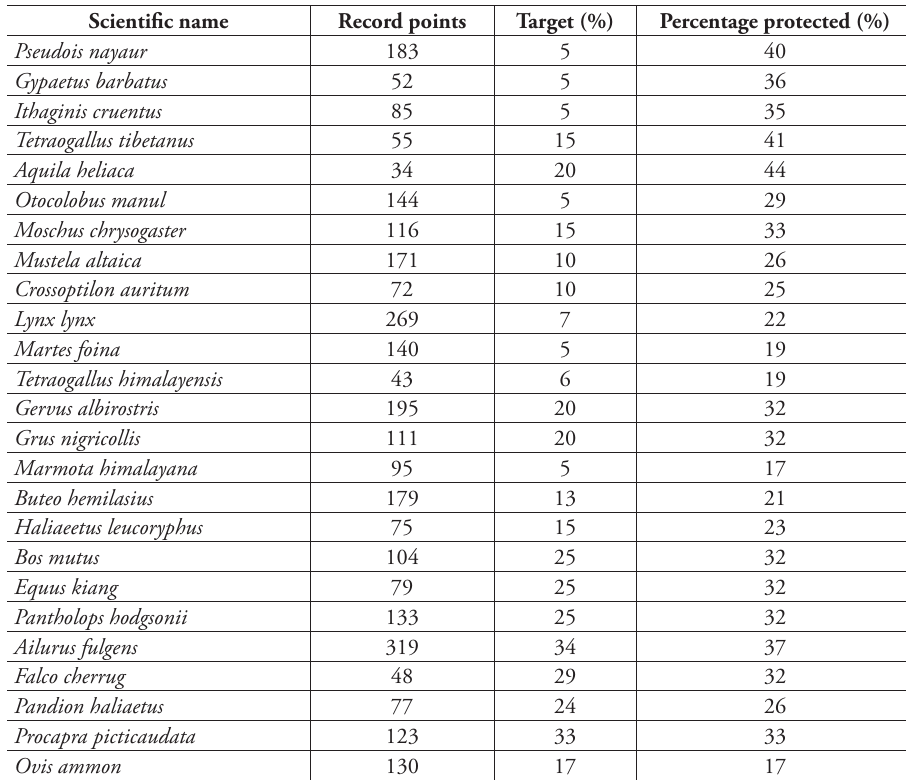
Table 2. Summary of species data source, the proposed conservation goal of each species according to their current conservation status, spatial distribution size and endemic status, and species representation (percentage protected) in the current nature reserve network of Qinghai Province based on the conserva- tion goals defined in this